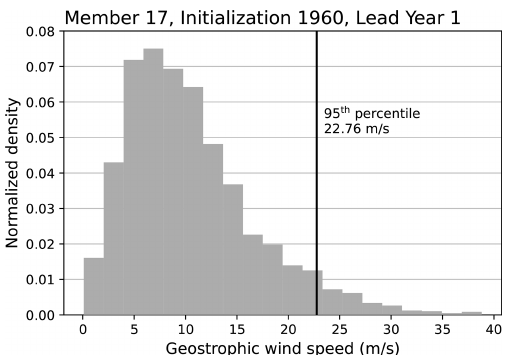
Figure 2. Exemplary distribution of predicted 3-hourly geostrophic wind speeds for lead year 1 from member 17, initialized in 1960. The vertical line marks the 95th percentile, which is used in the calculation of storm